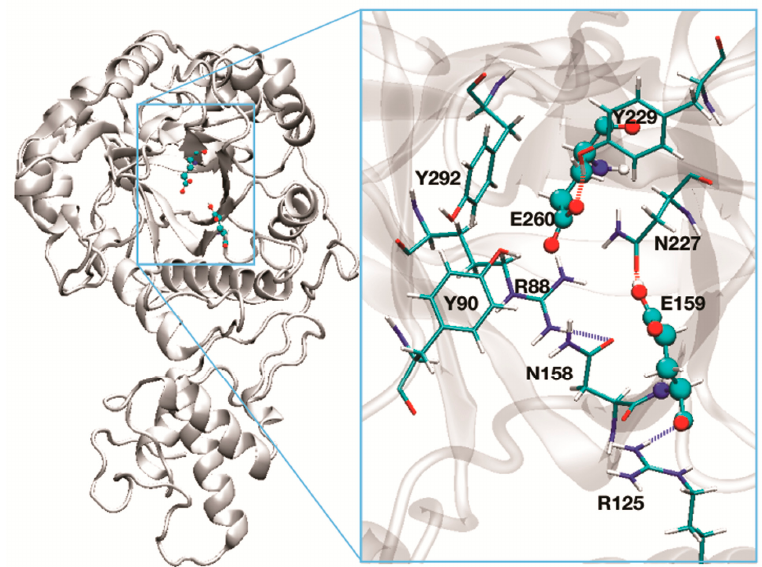
Figure 3. Molecular model of the three-dimensional structure of Phr2p of C. albicans . On the left is the full enzyme. On the right is the active site: E159, the acid/base group, and E260, the nucleophile (in ball-and-stick representation). Y90, Y292, Y229, and N227 are predicted to affect the dissociation state of the catalytic residues. R288, R125, and N158 are involved in shaping the active site pocket.